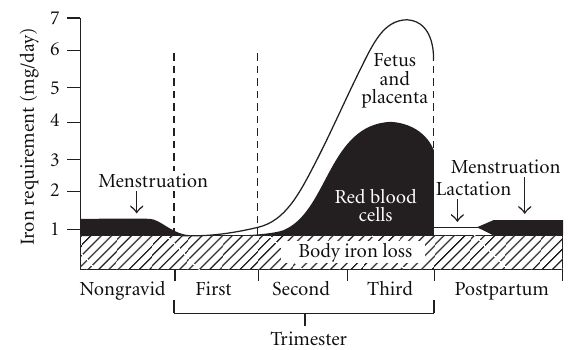
Figure 1: Requirements for absorbed iron in pregnant and lactating women; reproduced with permission [13].